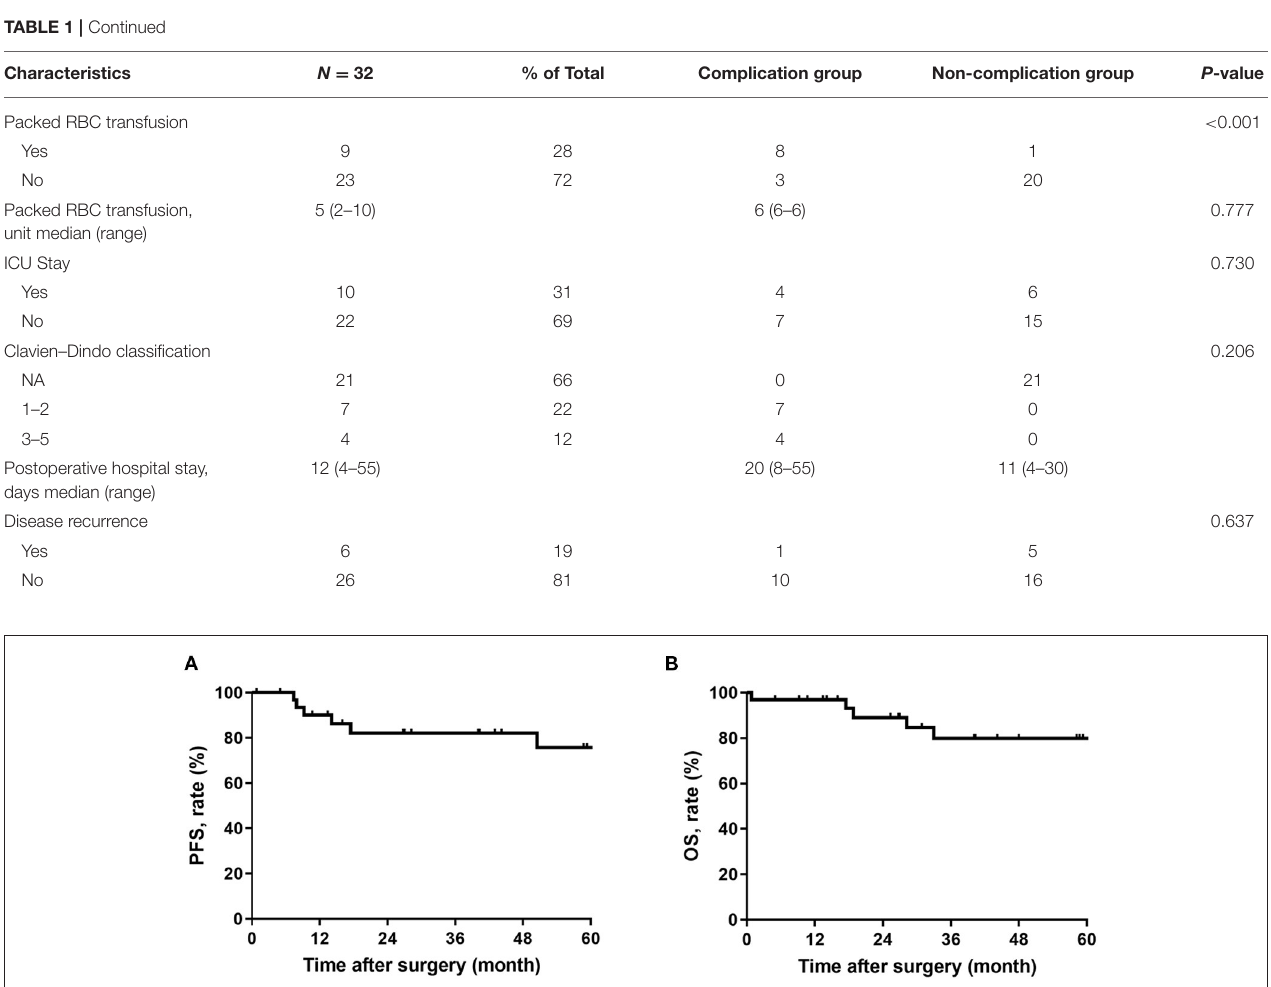
FIGURE 1 | (A) Progression-free survival in patients with retroperitoneal solitary fibrous tumor; (B) Overall survival in patients with retroperitoneal solitary fibrous